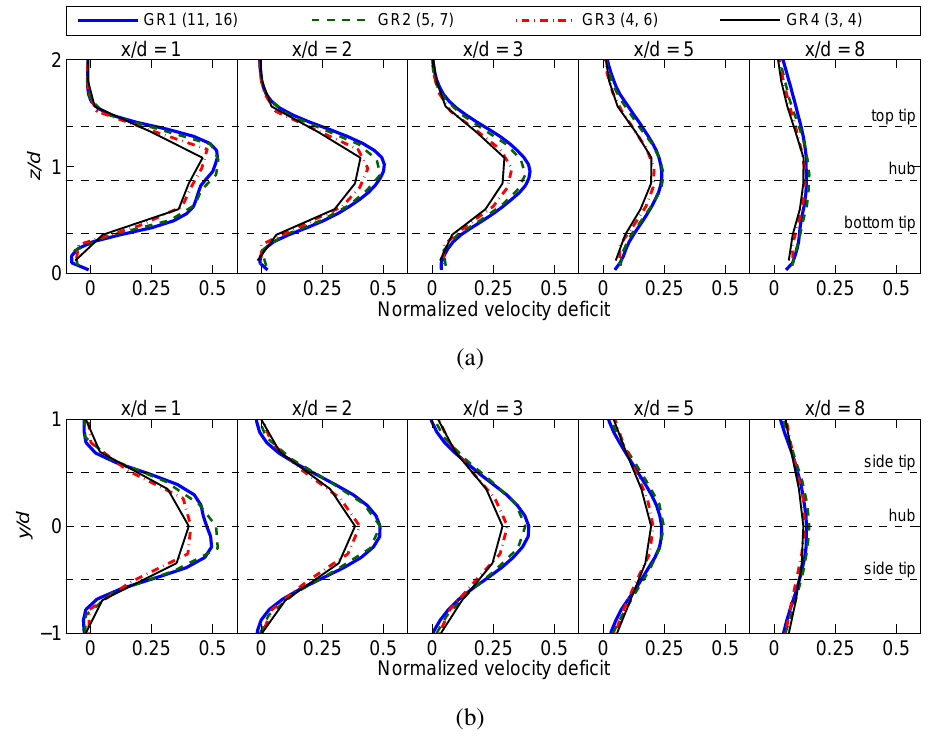
Figure 15. Comparison of vertical ( a ) and lateral ( b ) profiles of the normalized velocity deficit ∆ u/u through the centerline of the wakes. hub